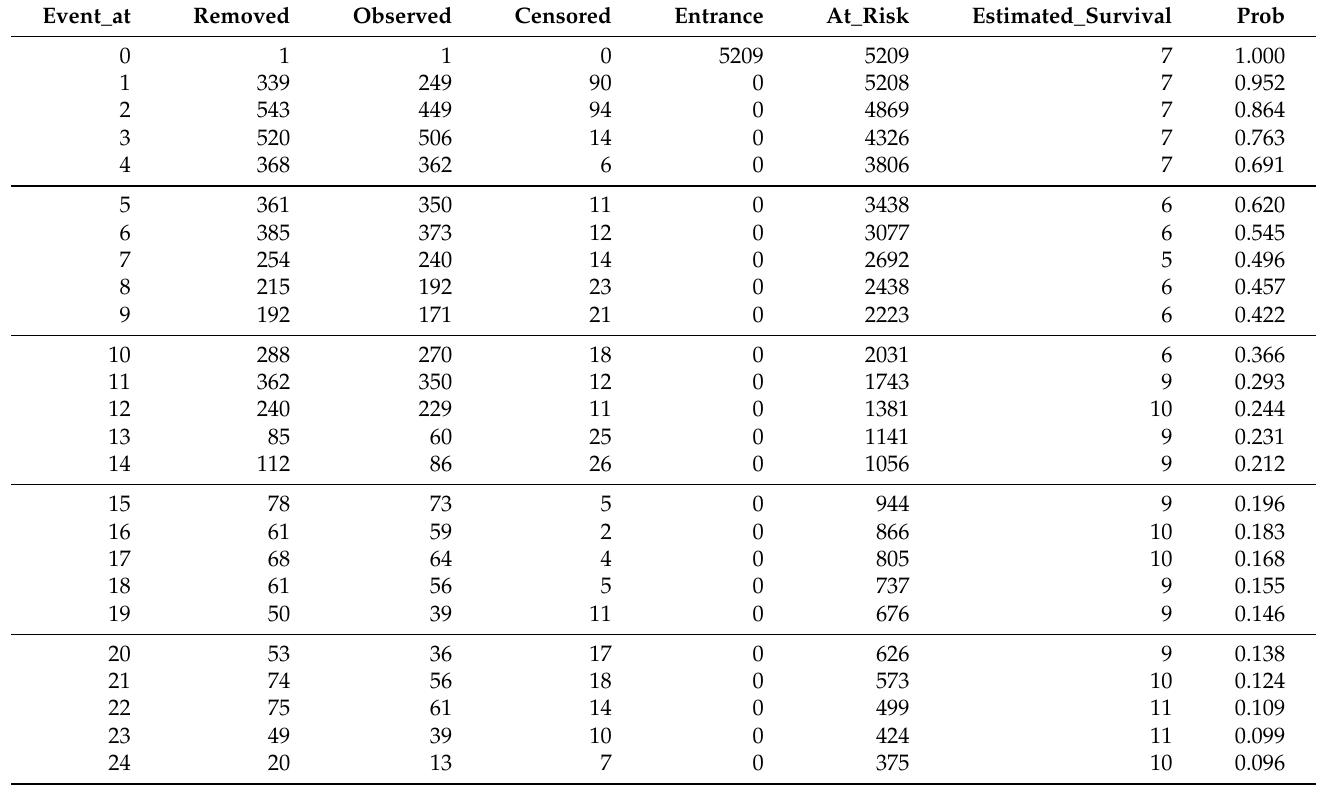
Table 2. Determination of survival time